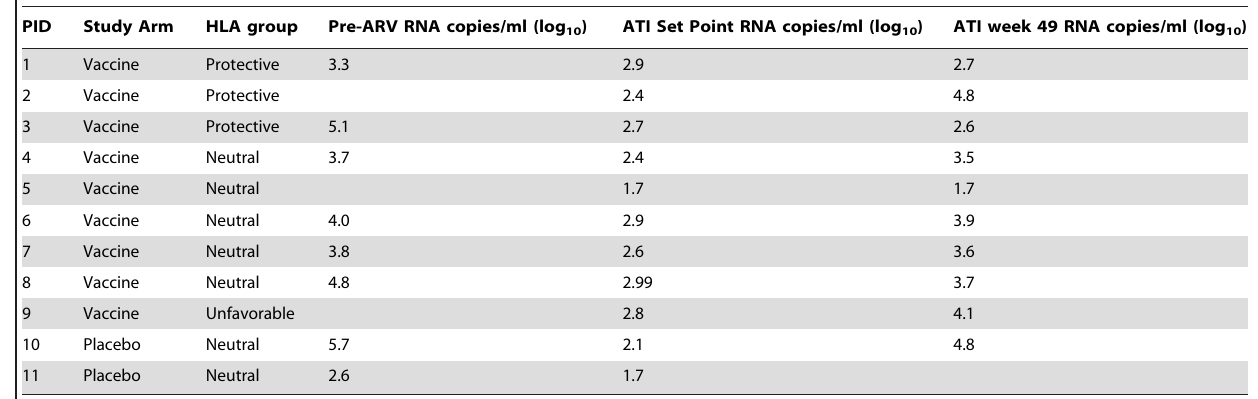
Table 2. Characteristics of initial viral suppressors.